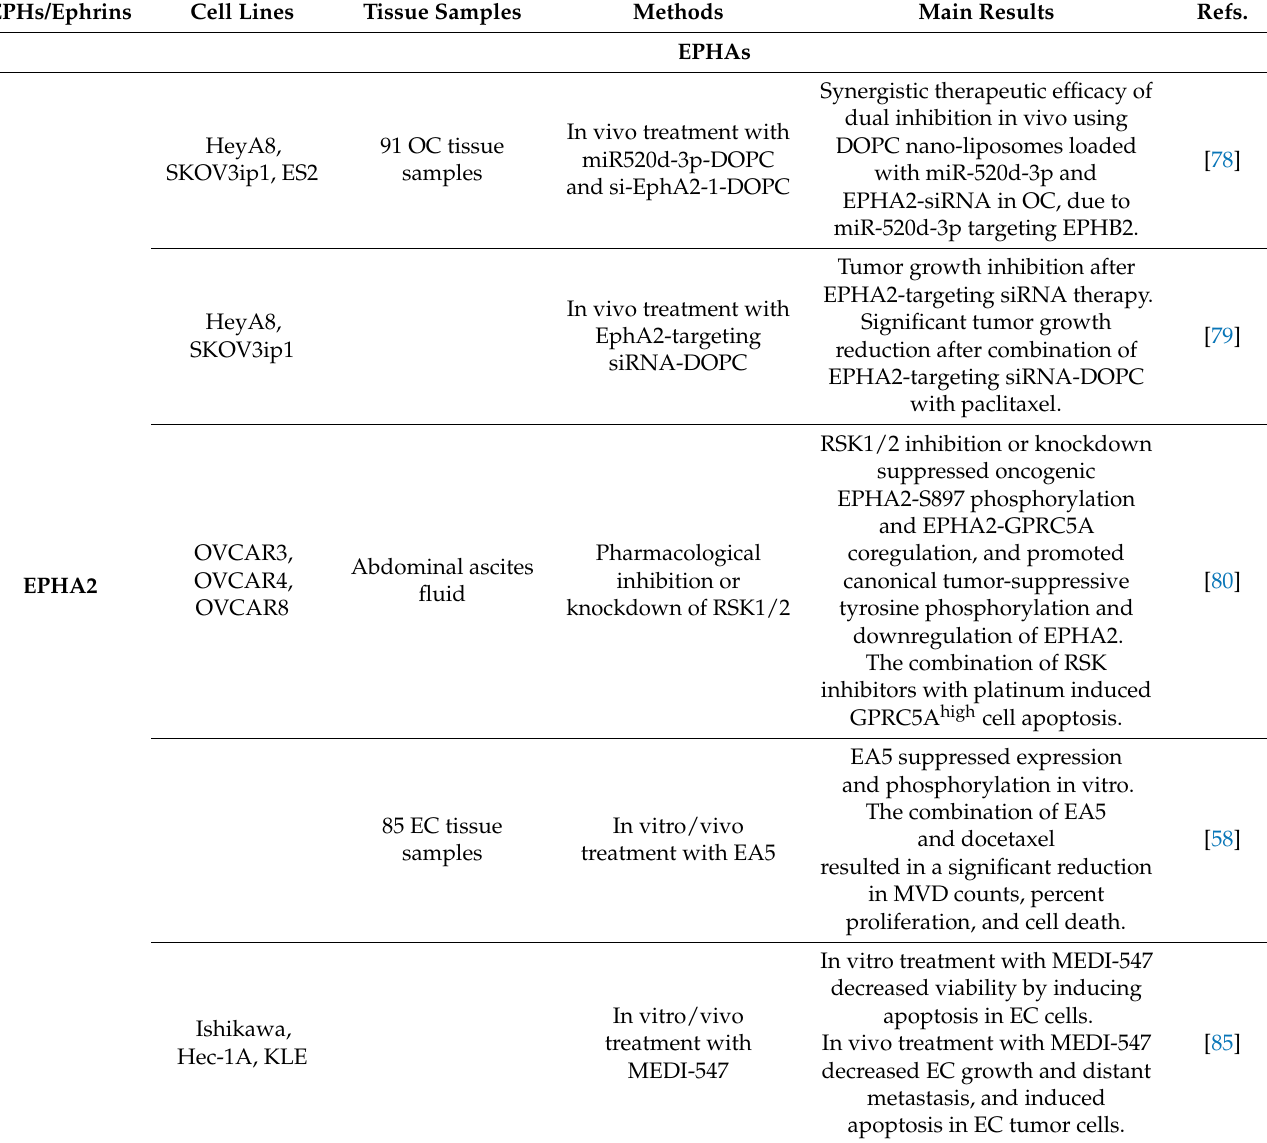
Table 8. Therapeutic agents targeting the EPH/ephrin system in